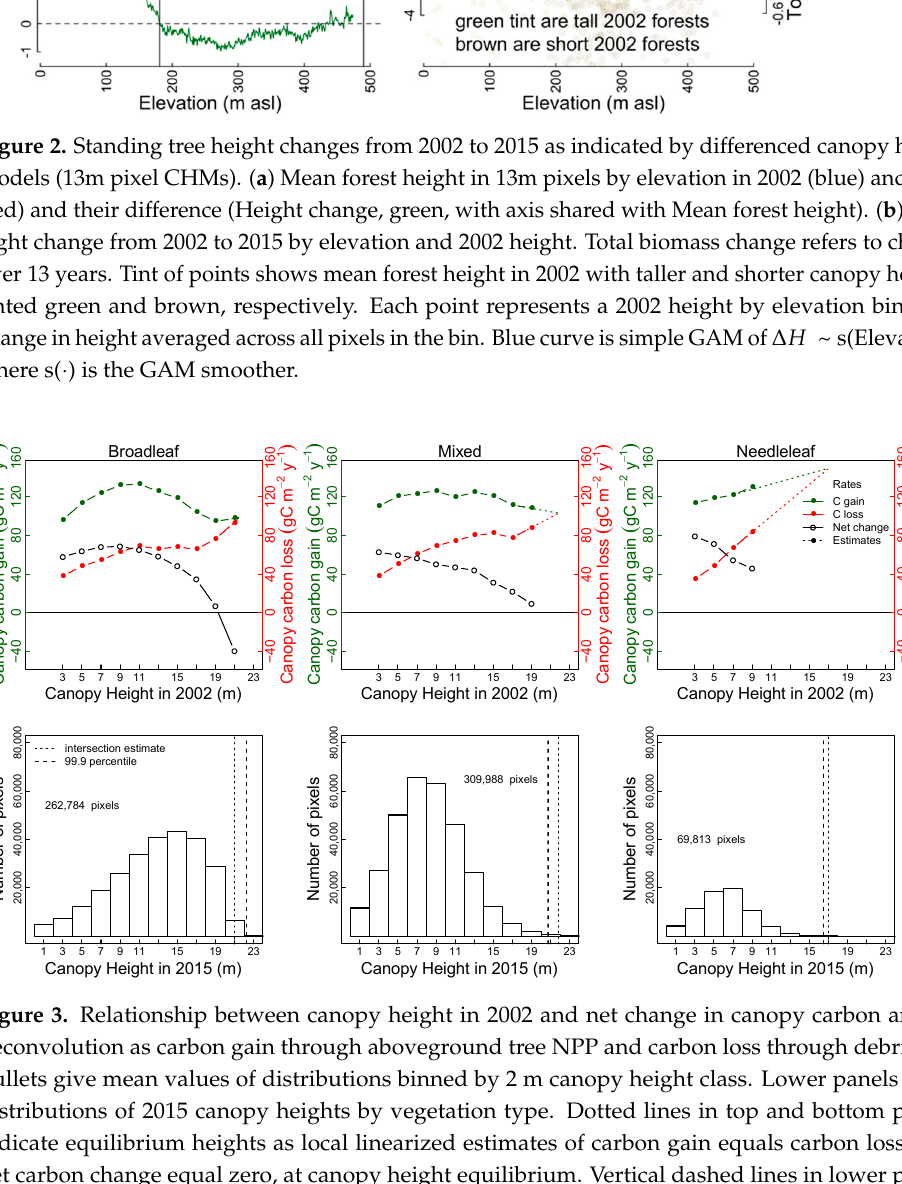
Figure 2. Standing tree height changes from 2002 to 2015 as indicated by differenced canopy height models (13m pixel CHMs). ( a ) Mean forest height in 13m pixels by elevation in 2002 (blue) and 2015 (red) and their difference (Height change, green, with axis shared with Mean forest height). ( b ) Total eight change from 2002 to 2015 by elevation and 2002 height. Total biomass change refers to change over 13 years. Tint of points shows mean forest height in 2002 with taller and shorter canopy heights tinted green and brown, respectively. Each point represents a 2002 height by elevation bin with change in height averaged across all pixels in the bin. Blue curve is simple GAM of ∆(cid:1834) ~ s(Elevation), where s( ∙ ) is the GAM smoother.